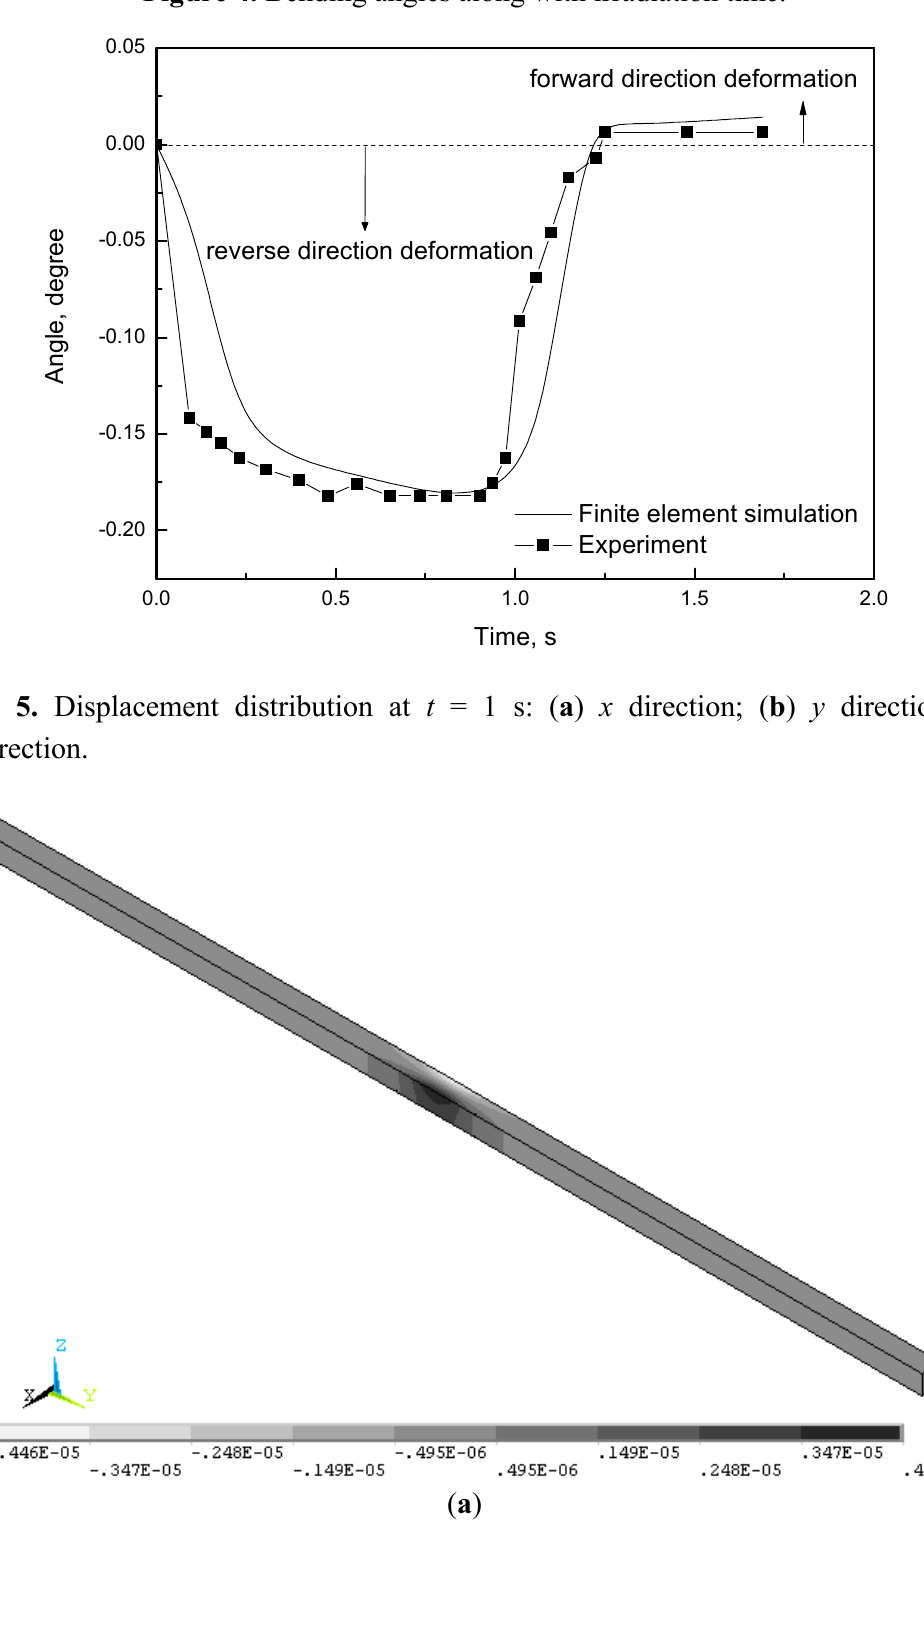
Figure 4. Bending angles along with irradiation time.